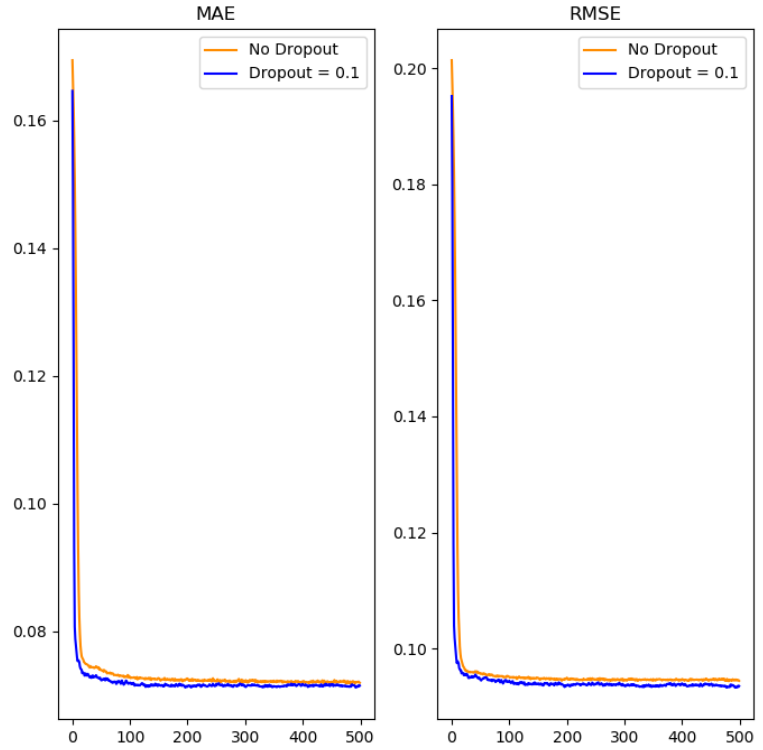
Figure 9. The effect of adding dropout between hidden layers on